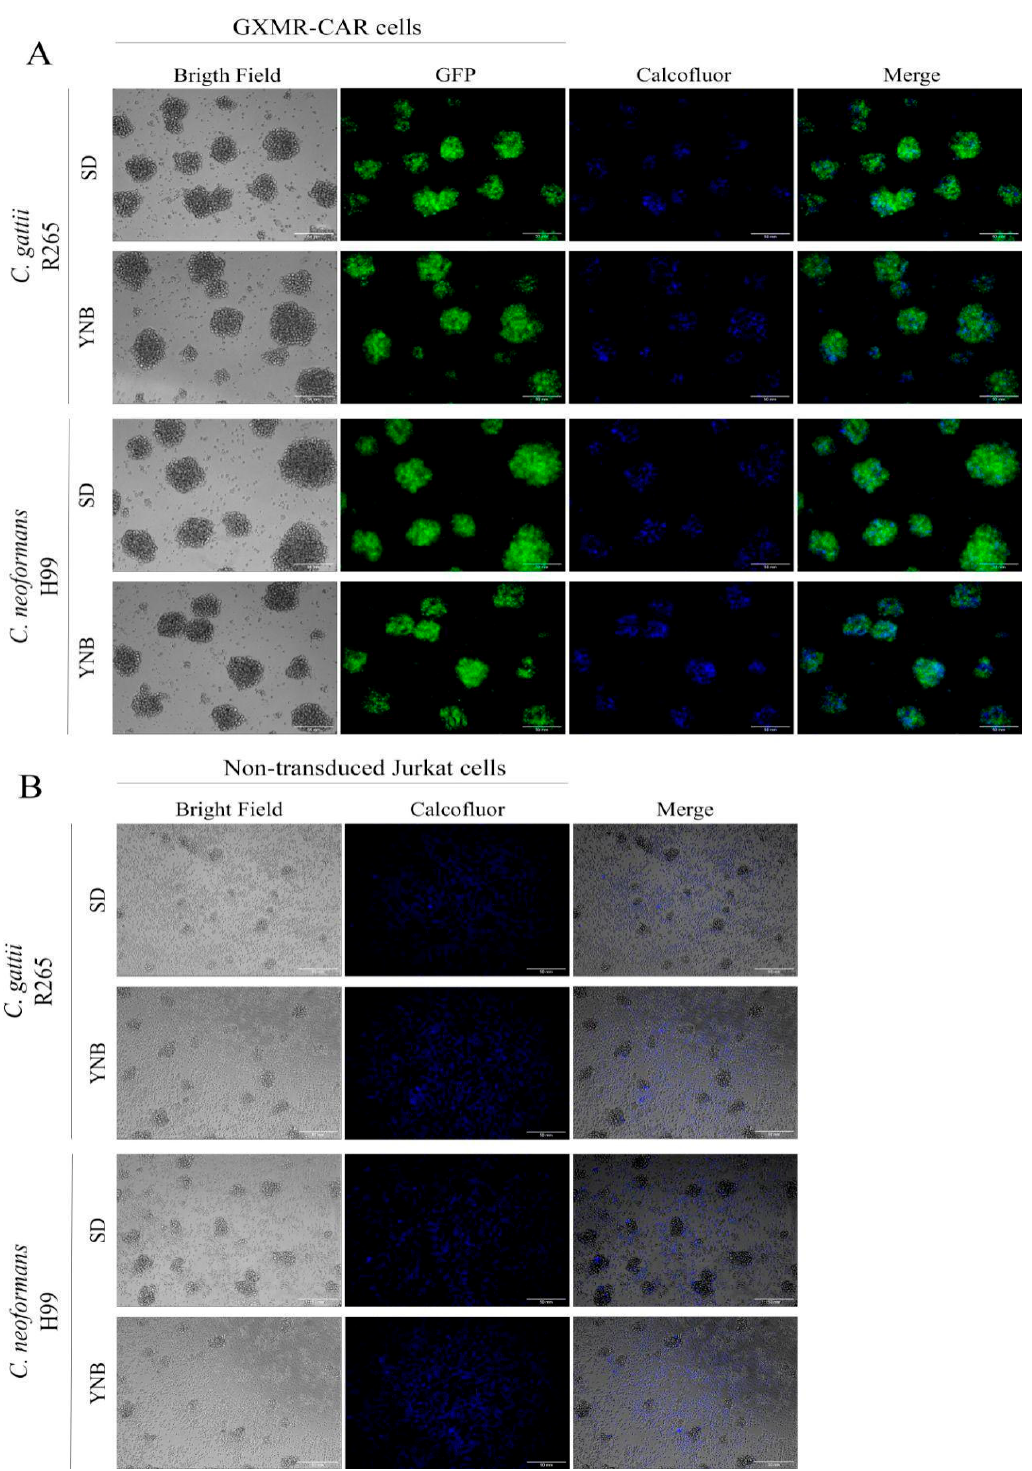
Figure 2. In vitro recognition of C. gattii and C. neoformans by GXMR-CAR cells. GXMR-CAR and non-transduced Jurkat cells were incubated with heat-killed C. gattii R265 or C. neoformans H99 yeasts grown in sabouraud dextrose (SD; thin capsule) or yeast nitrogen base (YNB; thick capsule) medium. Yeasts were labeled with Calcofluor-white and incubated with the cells for 5 h in a 1:1 ratio; the interaction was evaluated using fluorescence microscopy. The images were acquired at 200 × magnification. ( A ) GXMR-CAR cells and yeasts (bright field), GXMR-CAR cells (green, GFP), yeasts (blue, calcofluor), and their interaction (merge). ( B ) Non-transduced Jurkat cells and yeasts (bright field), and yeasts (blue, calcofluor), and their interaction